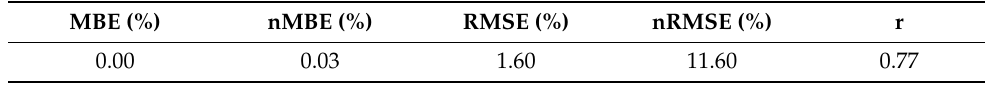
Table 7. Validation results of the soiling losses estimation without Isc.